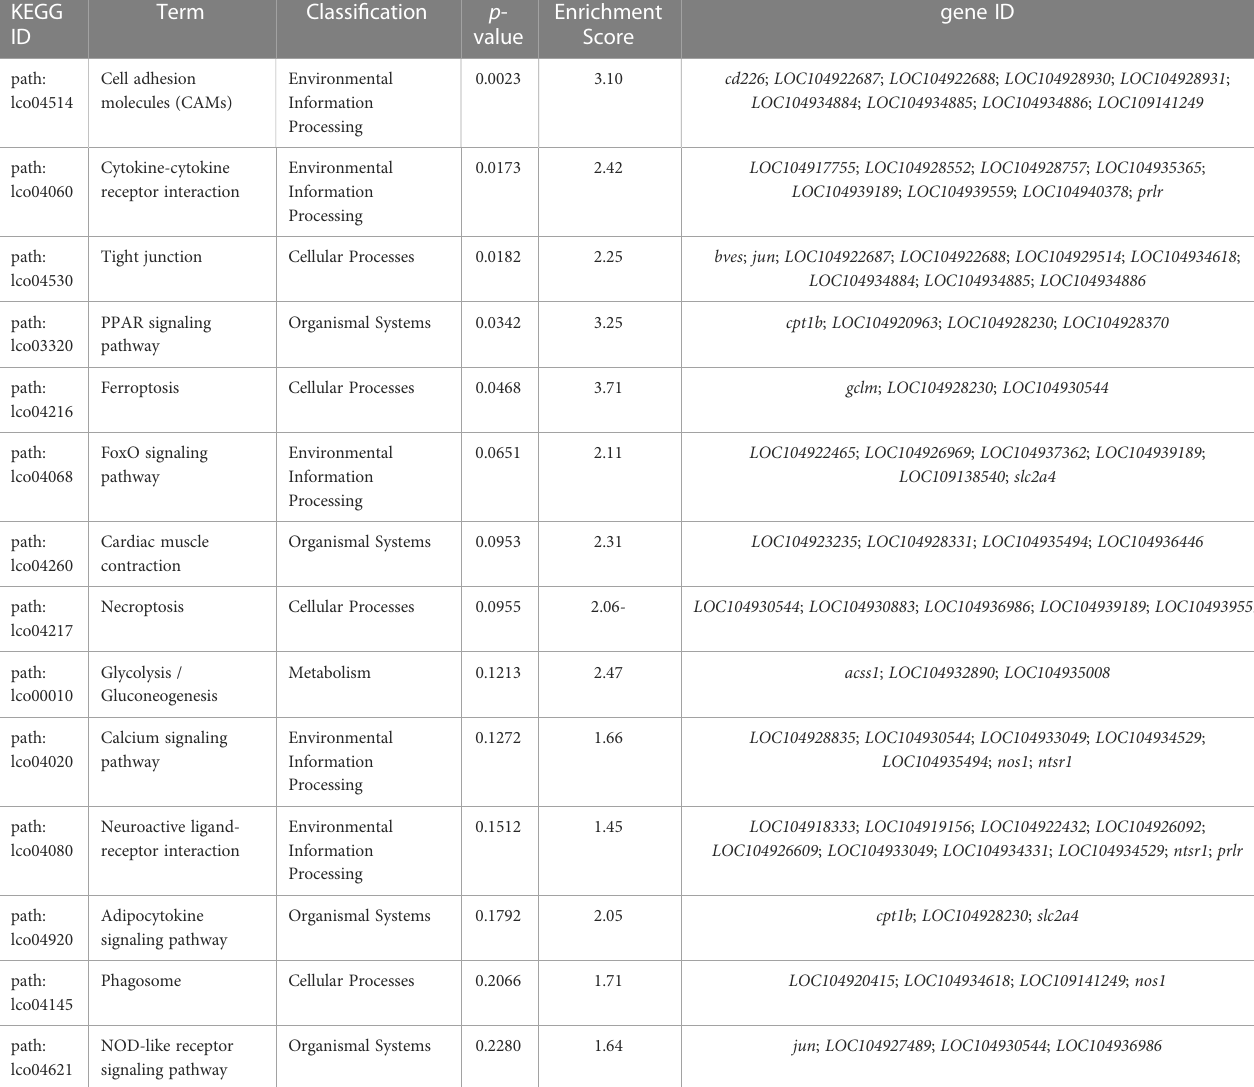
TABLE 9 TOP 20 KEGG pathways in gills of large yellow croaker under low-salinity